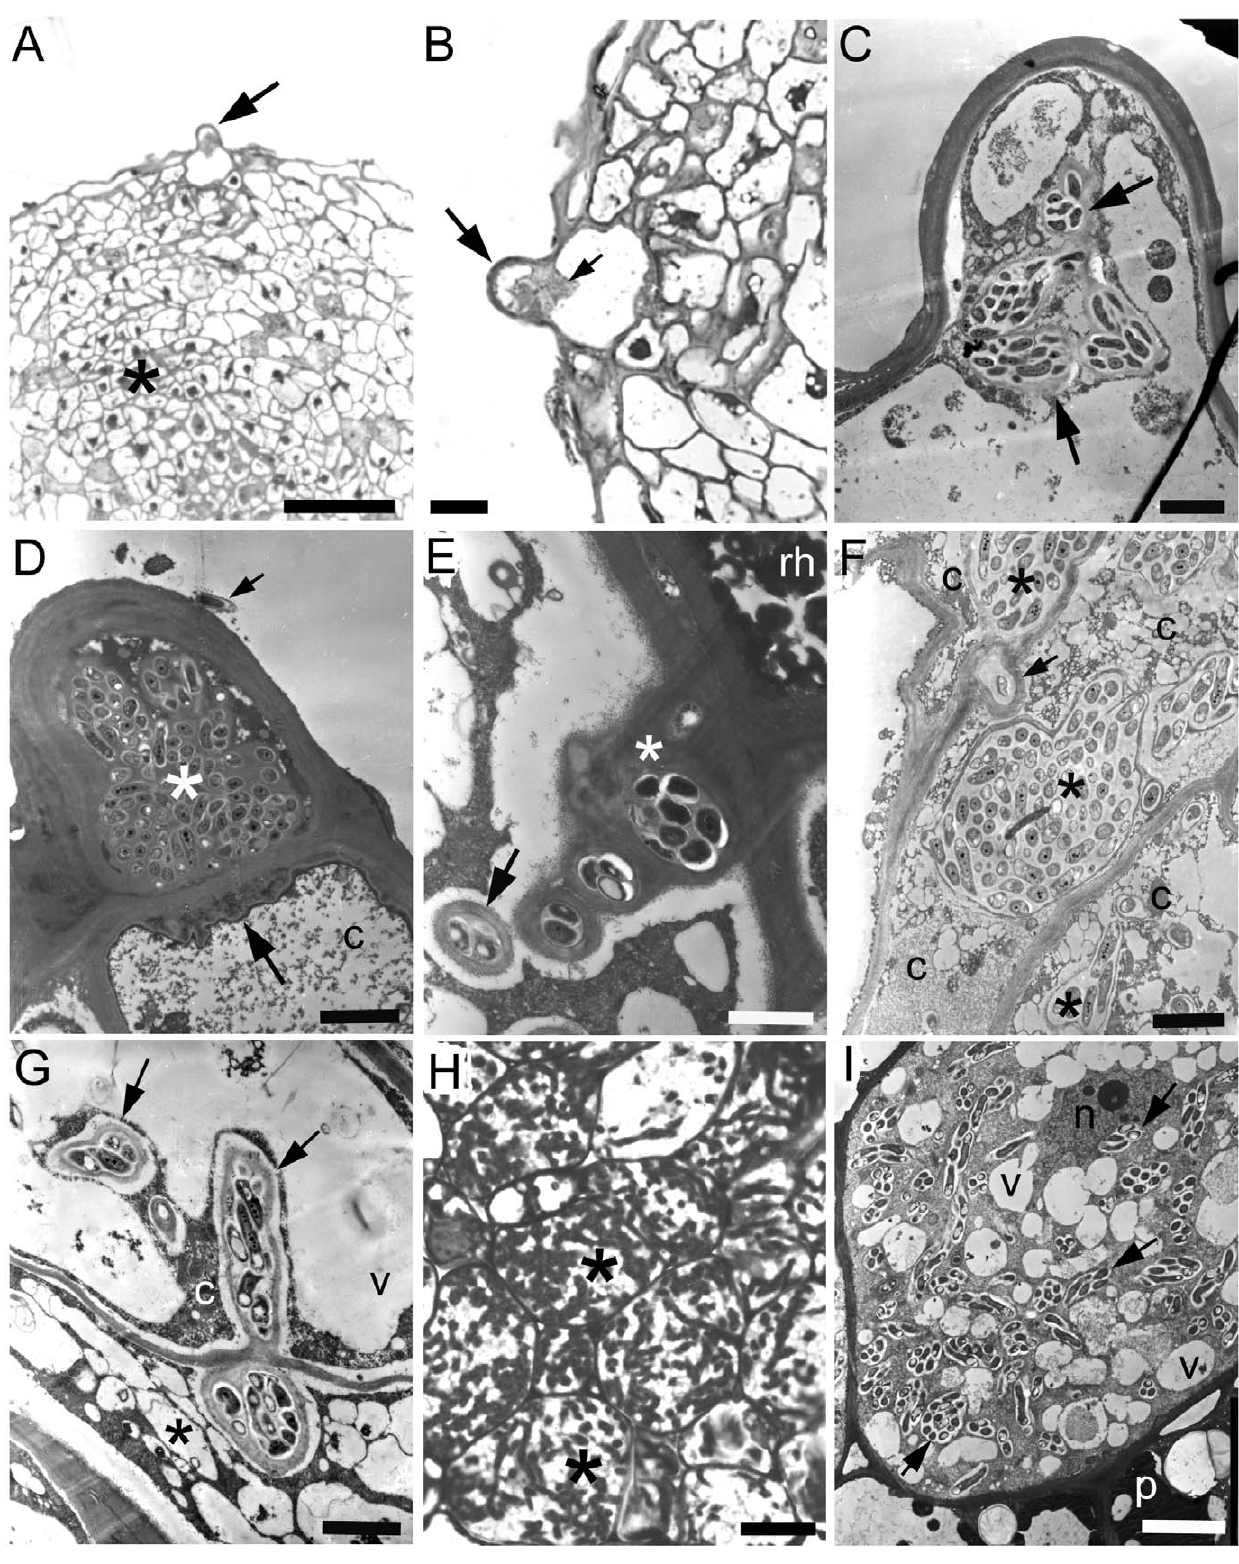
Figure 5. Light microscopy (A, B, H) and TEM (C–G, I) of the infection and development of N-fixing nodules on D.jorgei . These micrographs are of samples taken from nodulated roots at 60 dai with Bradyrhizobium elkanii strain SEMIA6099. (A) Root hair (arrow) at the tip of a nodule primordium consisting of newly-divided cells (*). (B) Higher magnification of the root hair (large arrow) showing that it appears to have been infected (small arrow). (C) Detail of the root hair confirming that it has been infected with bacteria; note that the bacteria are surrounded by a thick cell wall (arrows). (D) A root hair that is almost completely filled with bacteria that are embedded in an electron-dense matrix (*). There is a bacterium